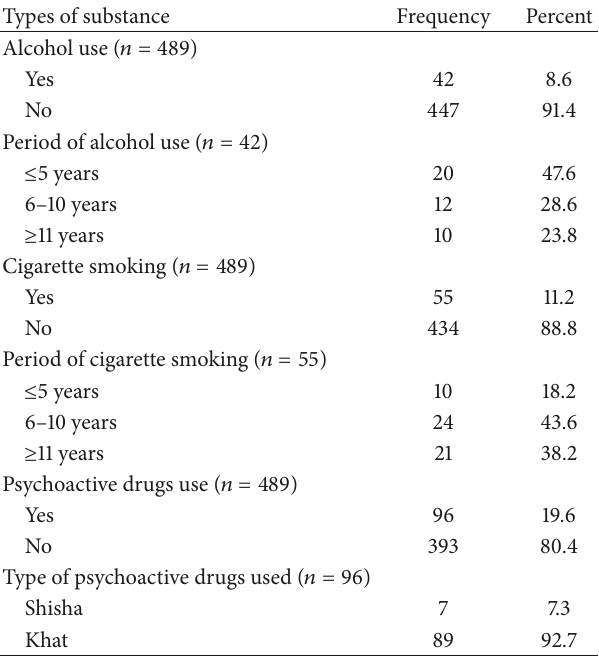
Table 3: Substance uses of respondents on depression and asso- ciated factors among adult inpatients in Harari region hospitals, Eastern Ethiopia, 2017.